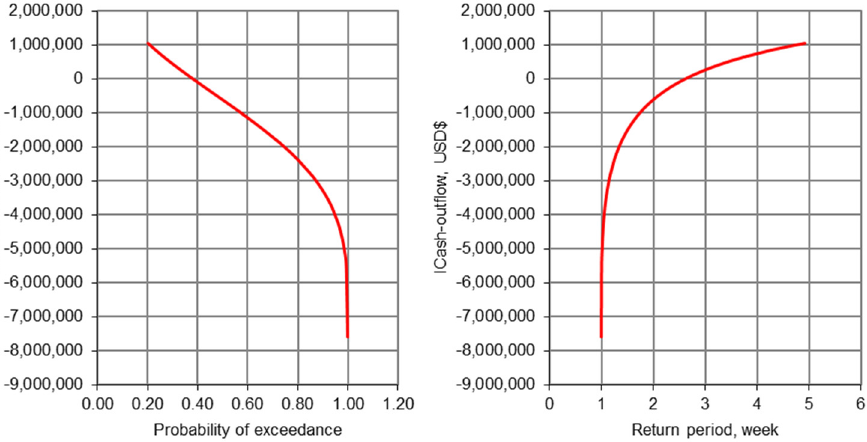
Figure 6. Cash-outflow return value ( right ) vs. probability of exceedance ( left ) and return period ( right ).